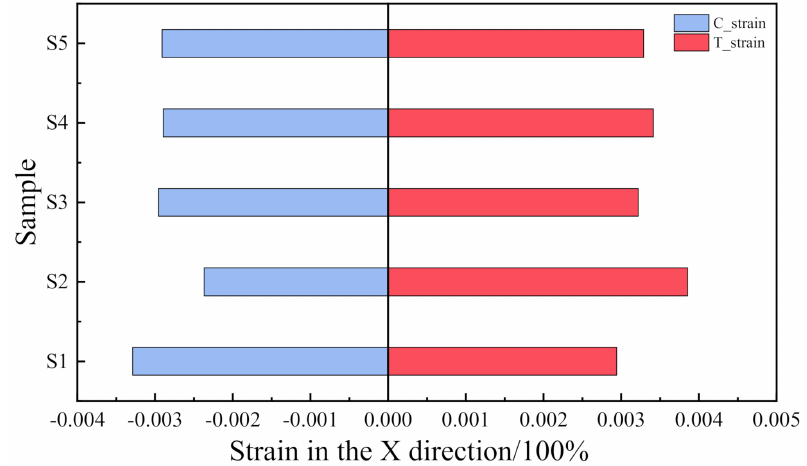
Figure 10. Strain comparison of OLED layer in the axial x direction with different profiles.